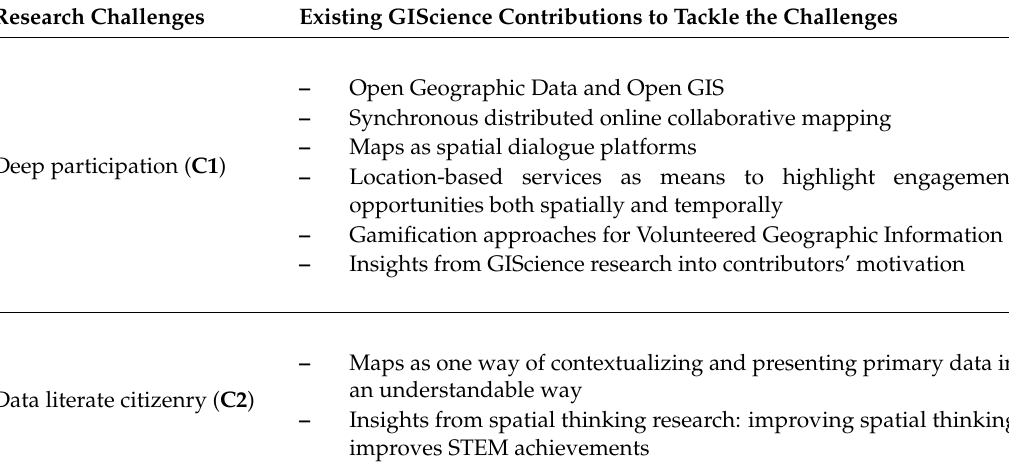
Table 1. Matching Geographic Information Science (GIScience) contributions to citizen-centric smart city challenges (Theme: empowering citizens). The use of maps is a promising approach to address both the issues of deep participation and data literate citizenry in a smart city